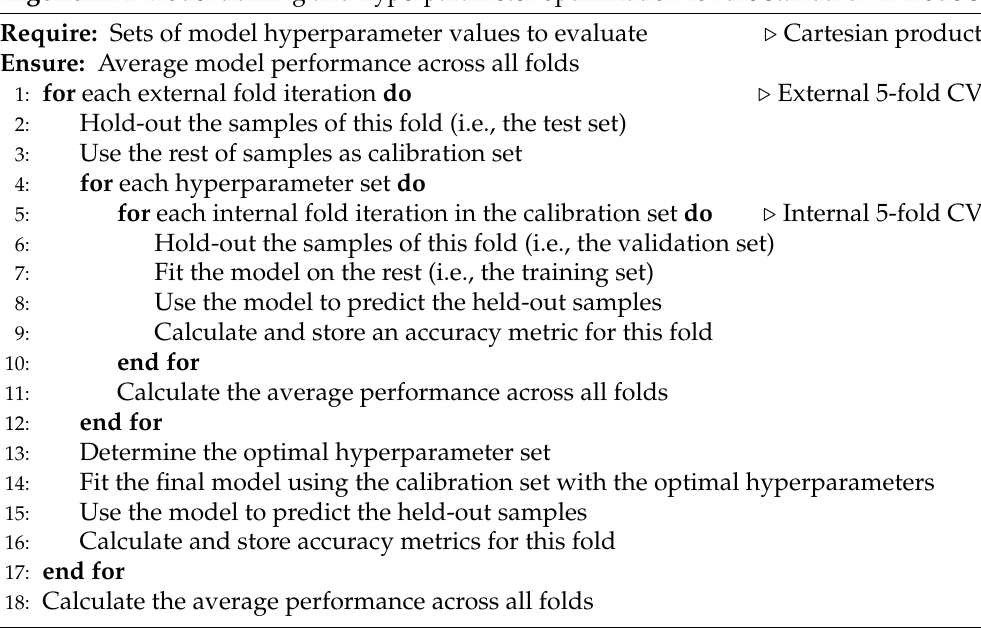
Figure 4. A kernel density estimation plot for the five different folds used per each variety. Algorithm 1 Model training and hyperparameter optimization for the standard AI